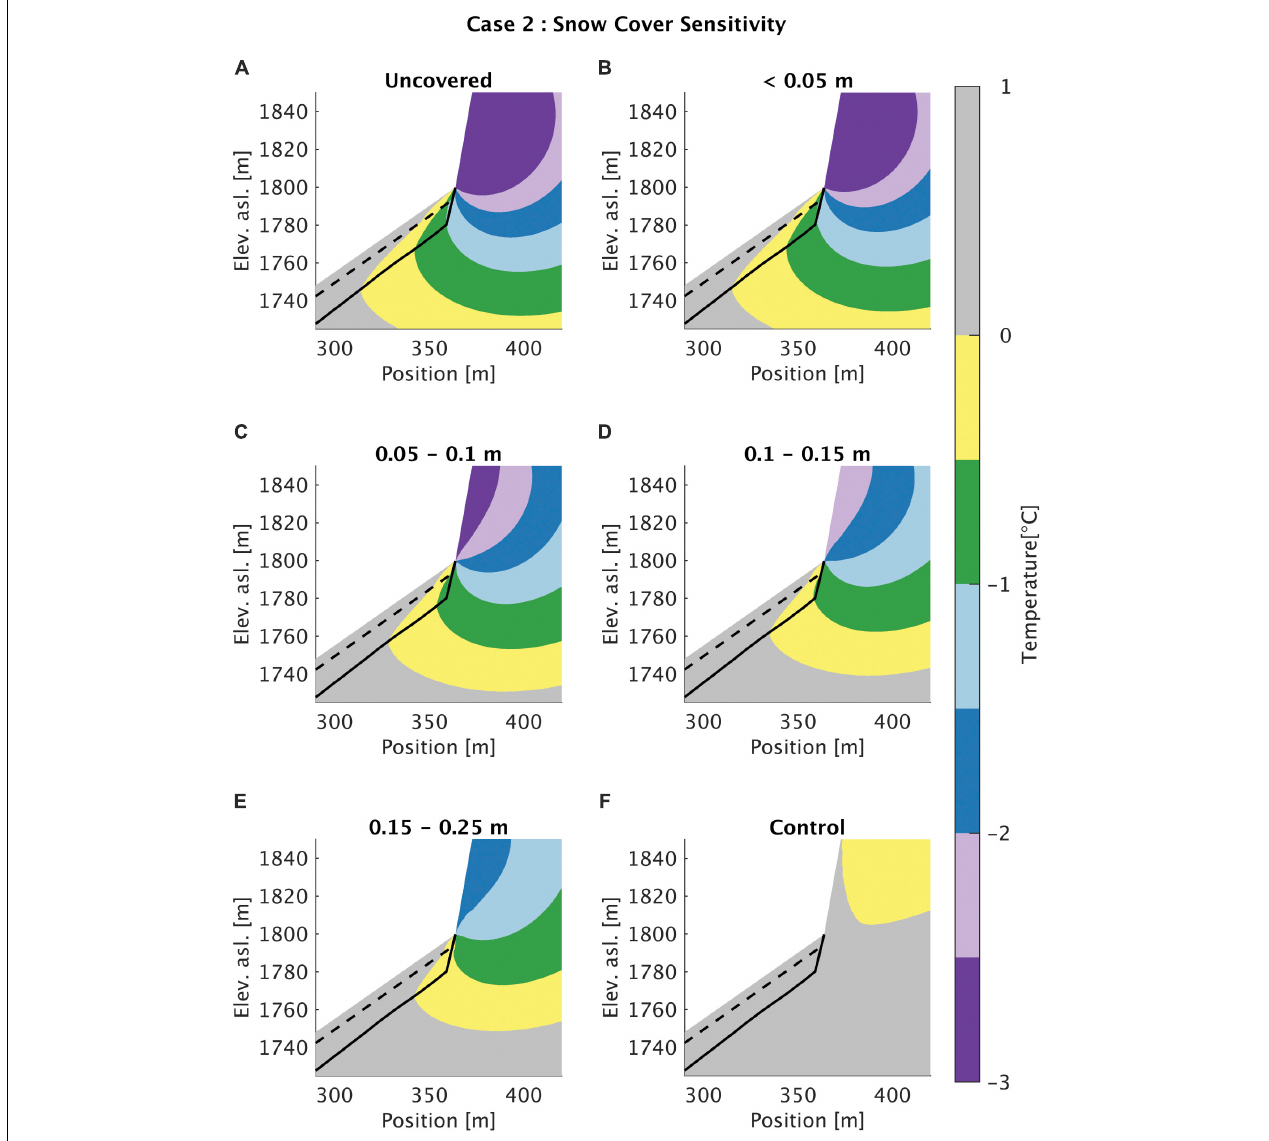
FIGURE 4 | Sensitivity study of heat flow between snow-covered talus slopes ( nF = 0.2) and steep rock walls with different annual mean snow thicknesses (AMHS) following Gisnås et al. (2013). (A) nF = 1 (Snow-free) (B) nF = 0.95 (AMHS: < 0.05 m) (C) nF = 0.7 (AMHS: 0.05–0.1 m) (D) nF = 0.6 (AMHS: 0.1–0.15 m) (E) nF = 0.5 (AMHS: 0.15–0.25 m) (F) nF = 0.2 (AMHS: > 0.8